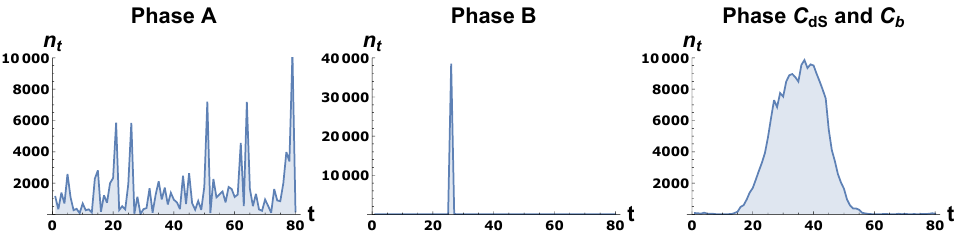
Figure 3. Typical volume profiles n t = N ( 4,1 ) ( t ) in various CDT phases in spherical spatial topology Σ = S 3 .